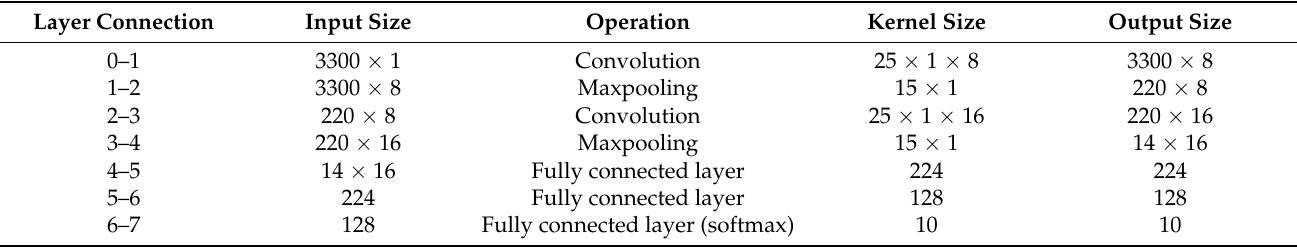
Table 1. Operation, input, and output of each layer in